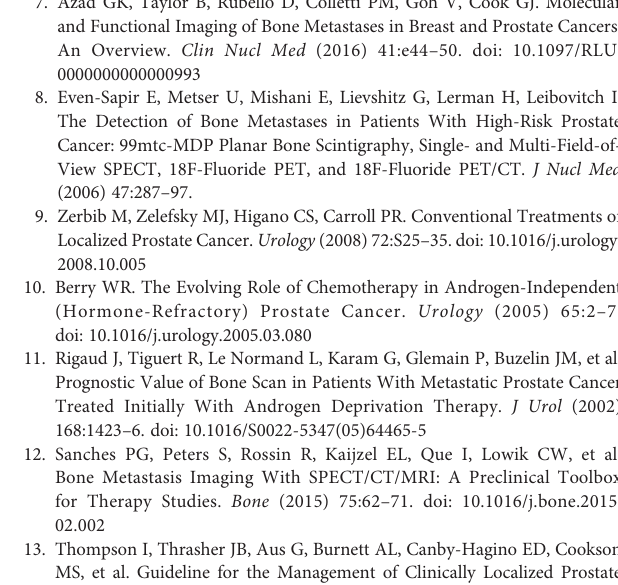
Supplementary Table 9 | Diagnostic data of the included studies on lesion- based level. Supplementary Table 10 | The results of quality assessment of the included studies. Supplementary Table 11 | PET/CT with different tracers for detecting bone metastasis in patients with PCa by deleting studies with only one diagnostic test. Supplementary Table 12 | PET/CT with different tracers for detecting bone metastasis in patients with PCa by deleting studies with a QUADAS-2 score of 7. Supplementary Table 13 | PET/CT with different tracers for detecting bone metastasis in patients with PCa by deleting study with the maximum sample size. Supplementary Table 14 | PET/CT with different tracers for detecting bone metastasis in patients with PCa by deleting study with the minimum sample size. Supplementary Table 15 | PET/CT with different tracers for detecting bone metastasis in patients with PCa by detecting studies published before 2010. Supplementary Table 16 | PET/CT with different tracers for detecting bone metastasis in patients with PCa based on clinical settings of cancers. Supplementary Table 17 | PET/CT with different trances for detecting bone metastasis in patients with PCa based on numbers of patients. Supplementary Table 18 | PET/CT with different tracers for detecting bone metastasis in patients with PCa based on ages of patients. Supplementary Table 19 | PET/CT with different tracers for detecting bone metastasis in patients with PCa based on continents of studies. Supplementary Table 20 | PET/CT with different tracers for detecting bone metastasis in patients with PCa based on study design. Supplementary Table 21 | PET/CT with different tracers for detecting bone metastasis in patients with PCa based on evaluation methods of imaging analyses. Supplementary Table 22 | PET/CT with different tracers and MRI with different fi eld strength for detecting bone metastasis in patients with PCa.